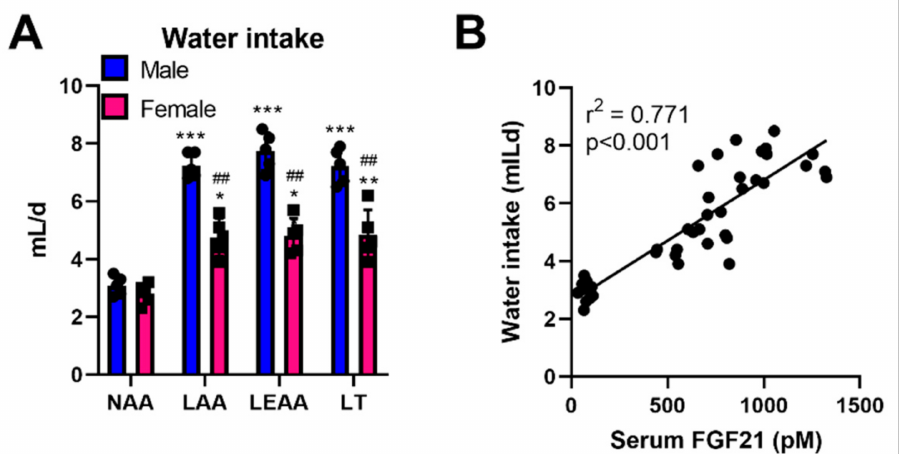
Figure 3. The hyperdipsic response to dietary AA restriction also occurs in fully mature female and male mice. Water intake of 6-month-old female and male mice treated with a normal amino acid diet (NAA, 18% energy from amino acids), a low AA diet (LAA, 4.5%), a low essential amino acid diet (LEAA) with EAA like in LAA and with non-EAA top-up to 18%, and a diet low in Threonine but with matching total AA to NAA (LT). Data are mean ± SEM ( n = 5 per group). Data were analysed by two-way ANOVA. Different than diet NAA: * p < 0.05, ** p < 0.01, *** p < 0.001. Different than diet male: ## p < 0.01. ( B ): Scatter plot of water intake and serum FGF21 levels of mice as in ( A ). Shown are r 2 and p values from Pearson’s